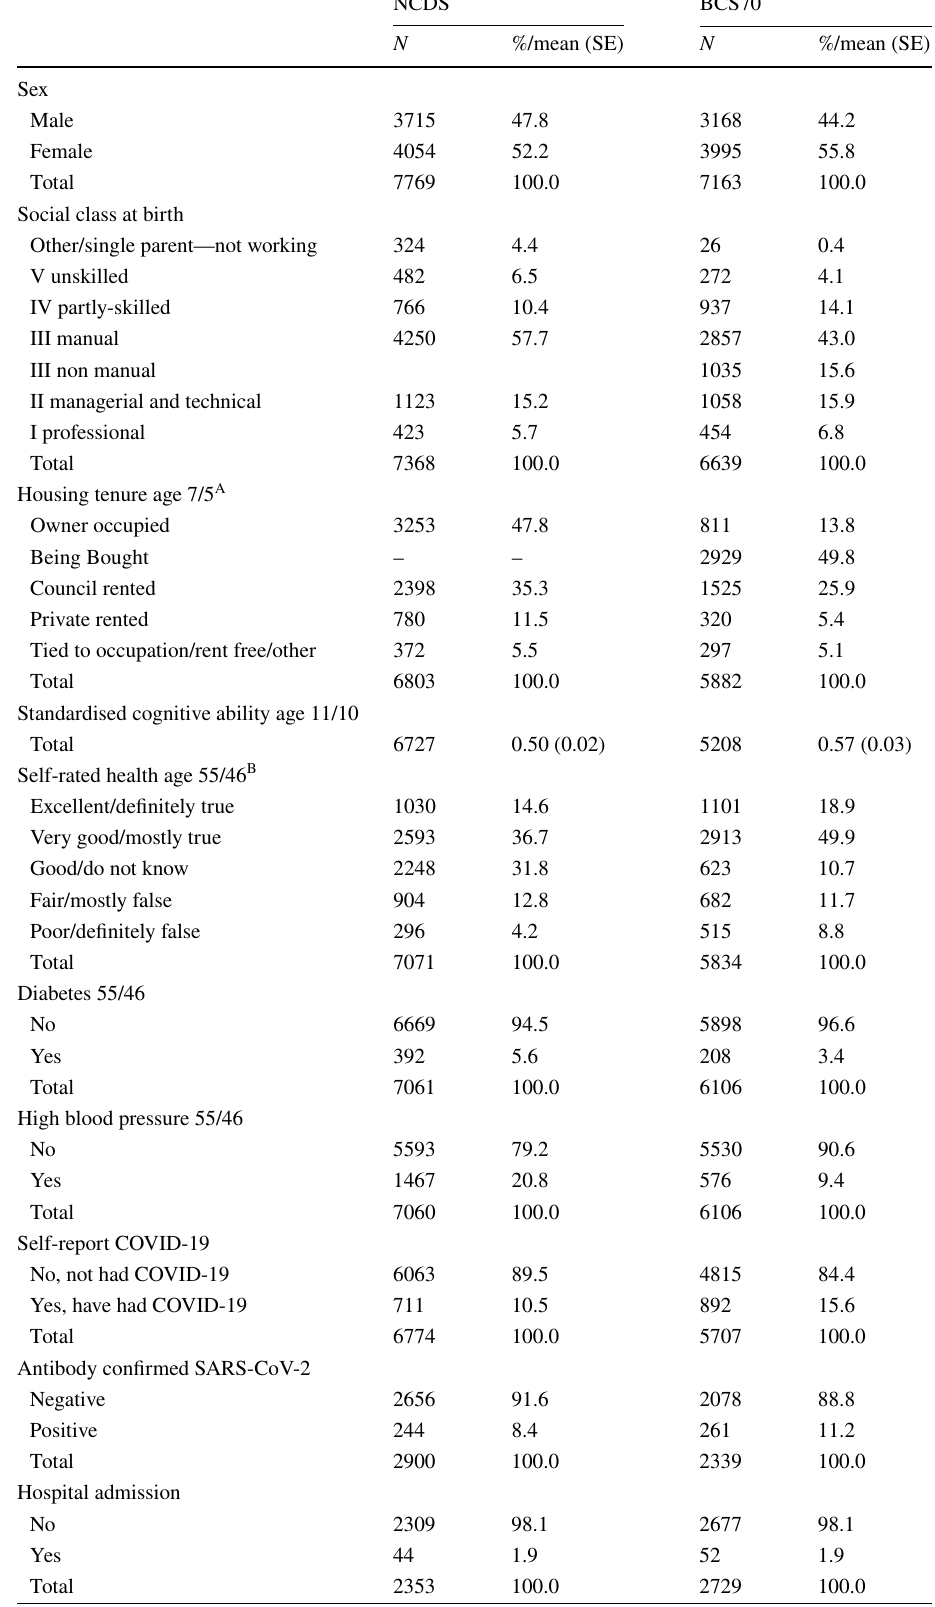
of Covariates, Mediators and Outcomes in BCS70 and